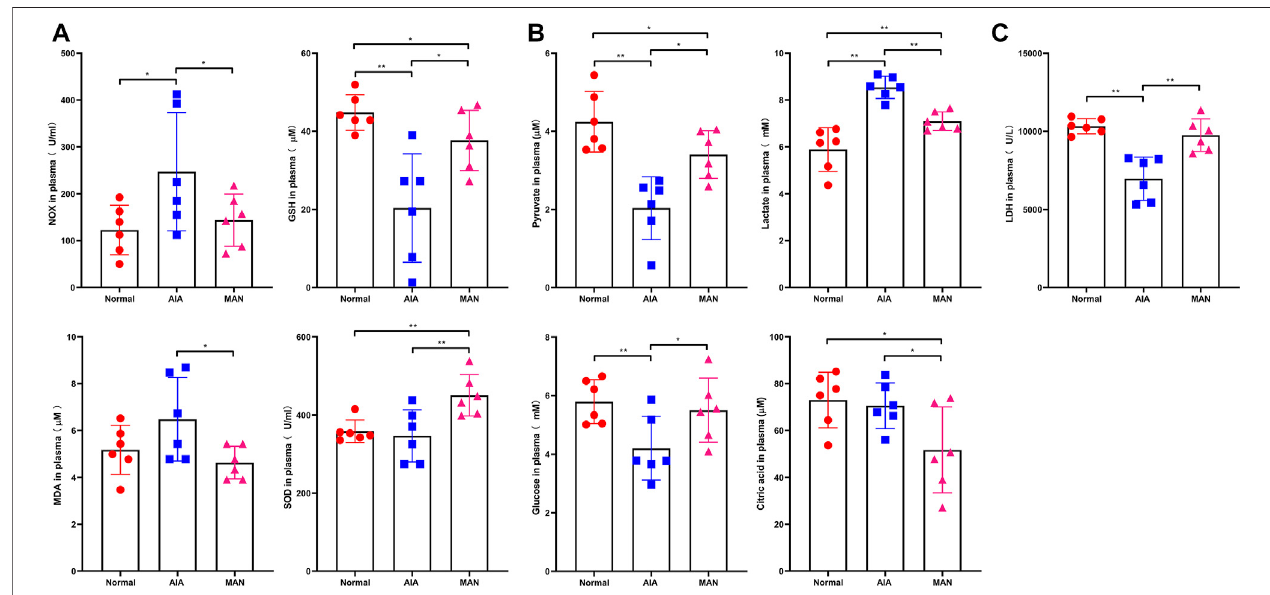
FIGURE4| MANrestoredoxidativestressandglycometabolismalterationinAIArats. (A) ,levelsofNOX,MDA,GSHandSODinplasma( n (cid:2) 6),andallparameters in this and following assays were detected using rat blood samples collected at day 27; (B) , levels of glucose, pyruvate, lactate and citric acid in plasma ( n (cid:2) 6); (C) , catalytic activity of LDH in the rat plasma (assessed by the production of pyruvate ex vivo , n (cid:2) 6).